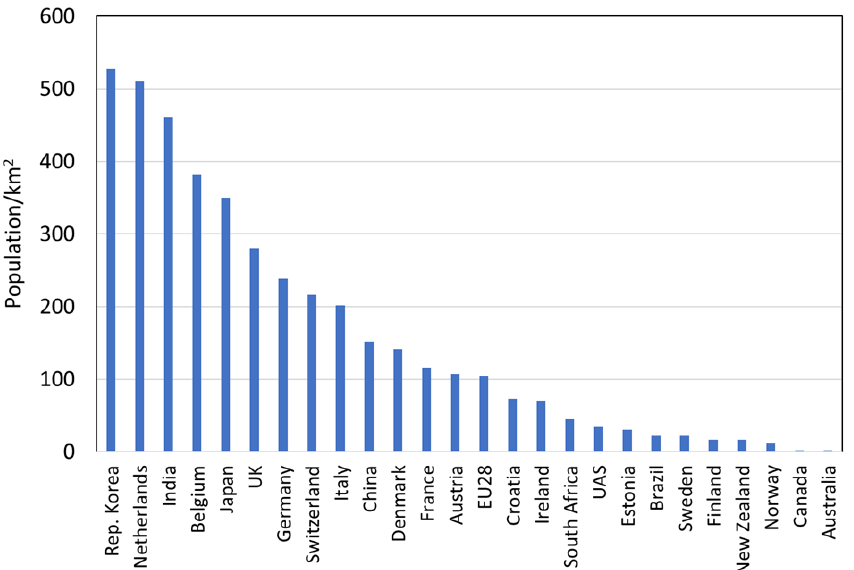
Figure 6. Population density of IEA bioenergy member countries, data from FAOSTAT, 2018